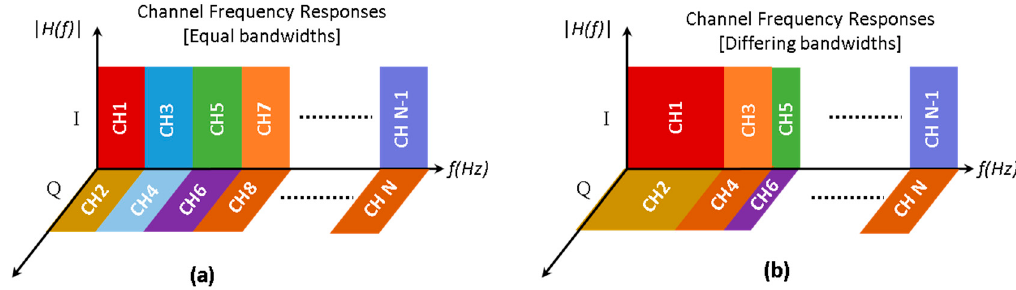
Figure 2. Example electrical spectra of combinations of digital orthogonal filter multiplexed channels. ( a ) Equal bandwidth channels; ( b ) varying bandwidth channels.